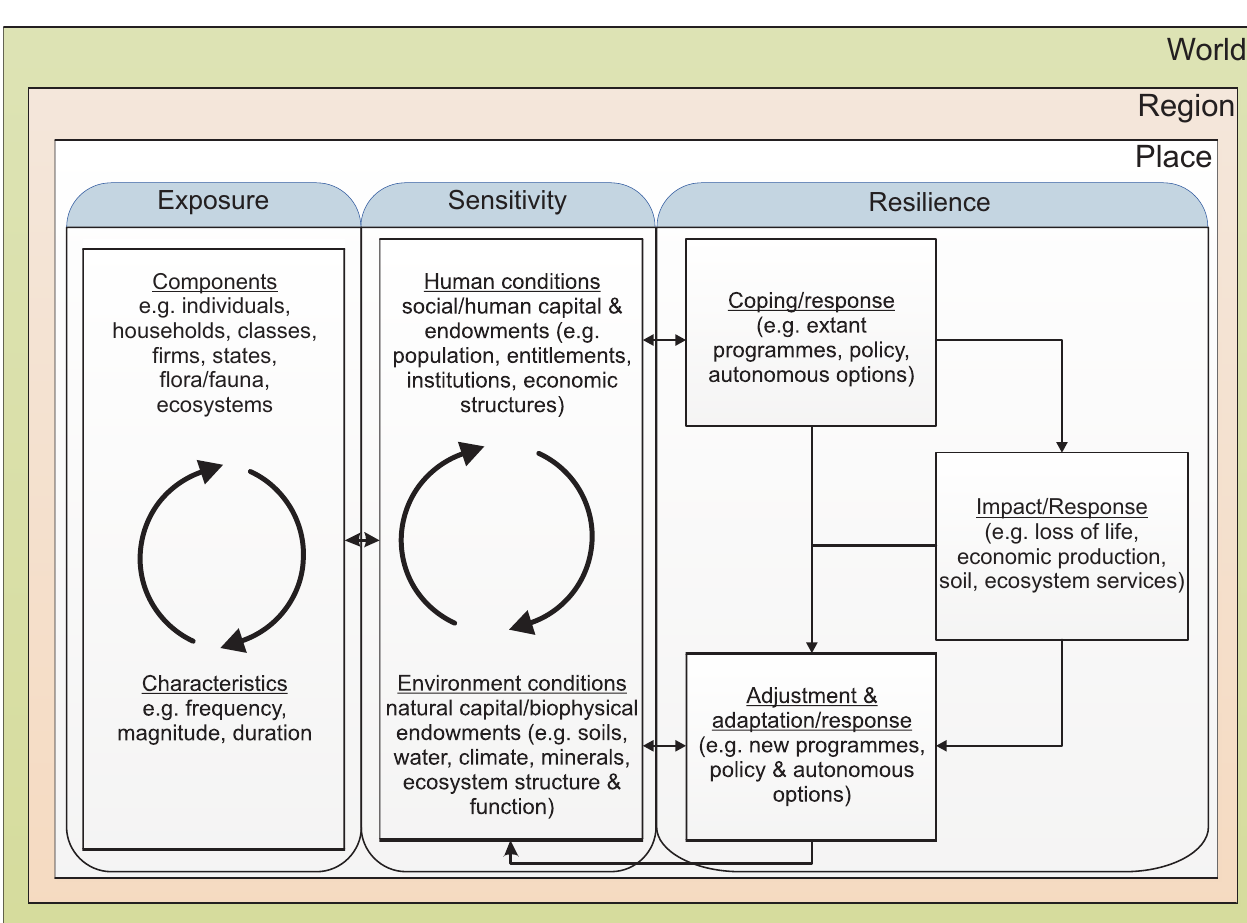
Fig. 1. Vulnerability framework (Based on Turner et al.,